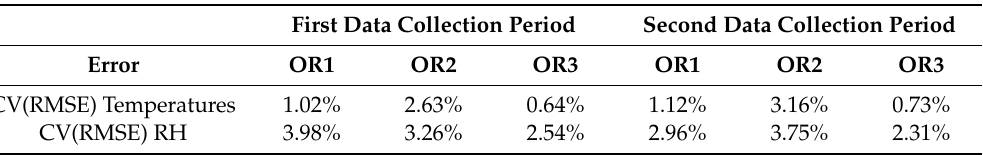
Table 5. Coe ffi cient of variation of the root mean square error (CV(RMSE)) of temperature and RH of the ORs during the two experimental